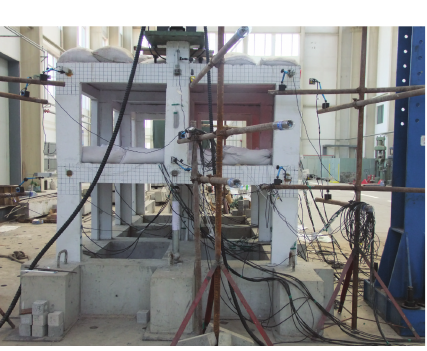
Figure 3: Reinforcement details of beam-column joints.